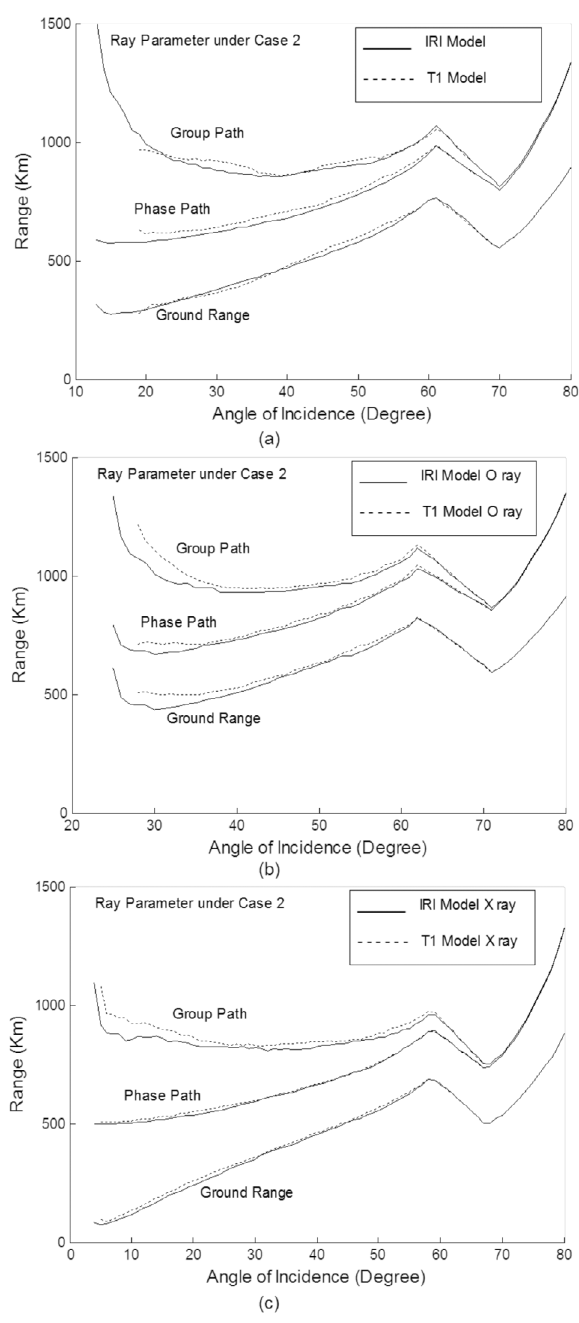
Figure 6. Ray tracing parameter variation for different angle of in- cidence at 7.5 MHz under Case 2 for: (a) ray tracing without influ- ence of Earth’s magnetic field (b) O mode propagation (c) X mode